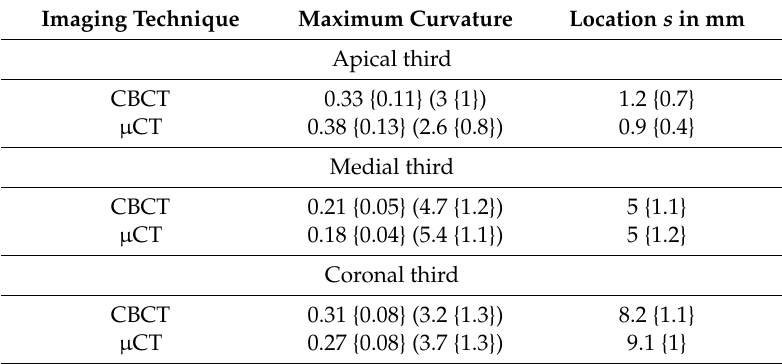
Table 4. Median and quartile deviation of the maximum